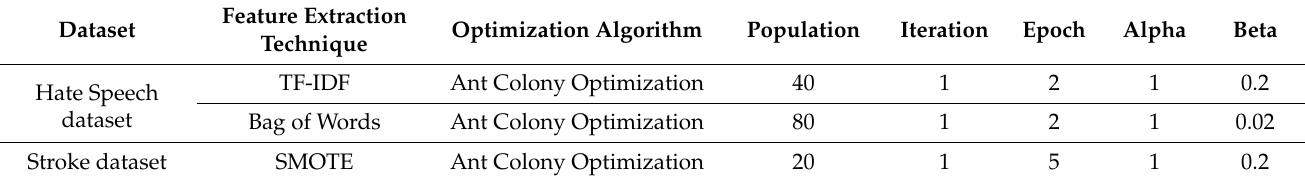
Table 3. Parameter settings of Ant Colony Optimization